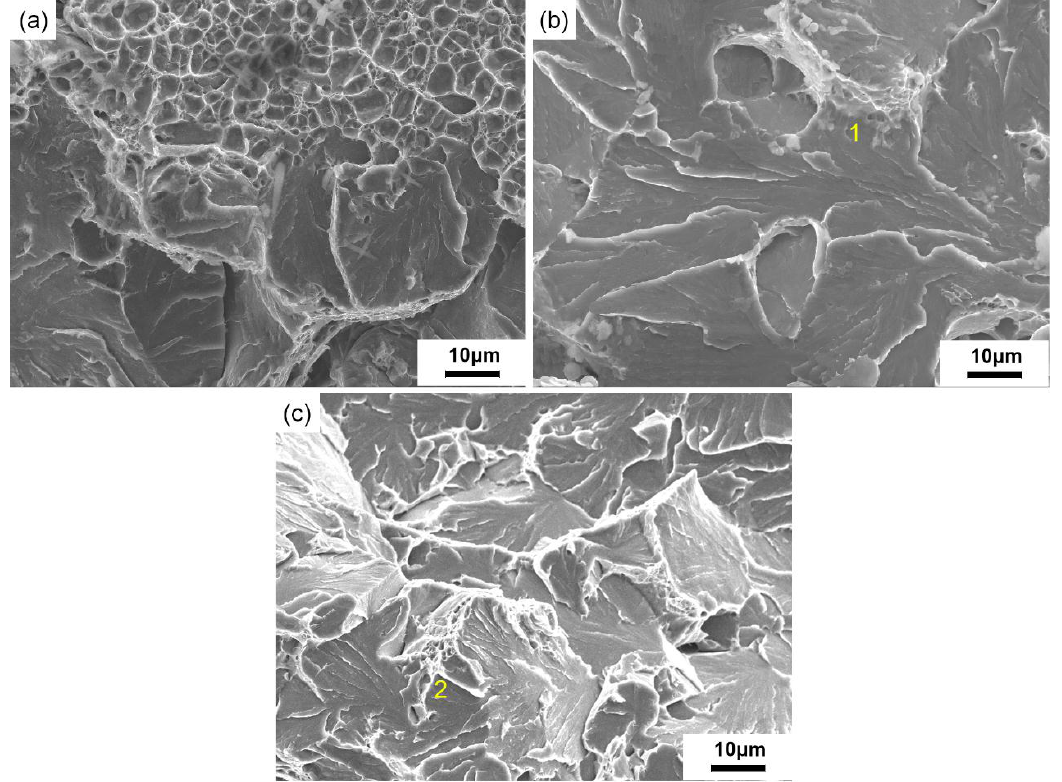
Figure 13. The SEM impact fracture of SA 508–3 under reduction ratios when the deformation temperature is 950 °C: ( a ) 10%, ( b ) 20%, and ( c ) 30%.